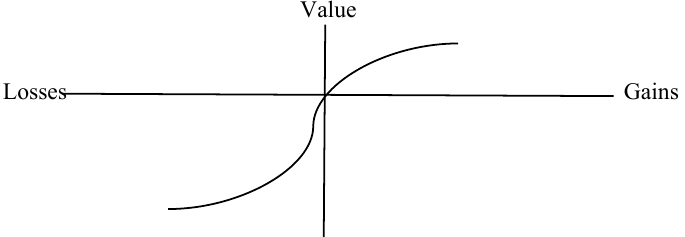
Fig. 1. Hypothetical value function (Gomes & Lima,